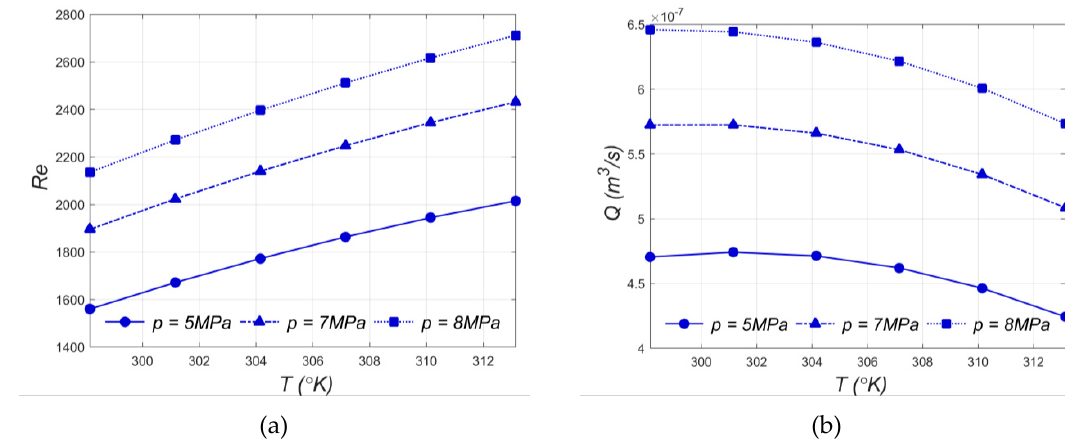
Figure 9. Impact of the initial temperature of fluid T and initial working fluid inlet pressure p on ( a ) the Reynolds number Re and ( b ) the volumetric flow rate Q .